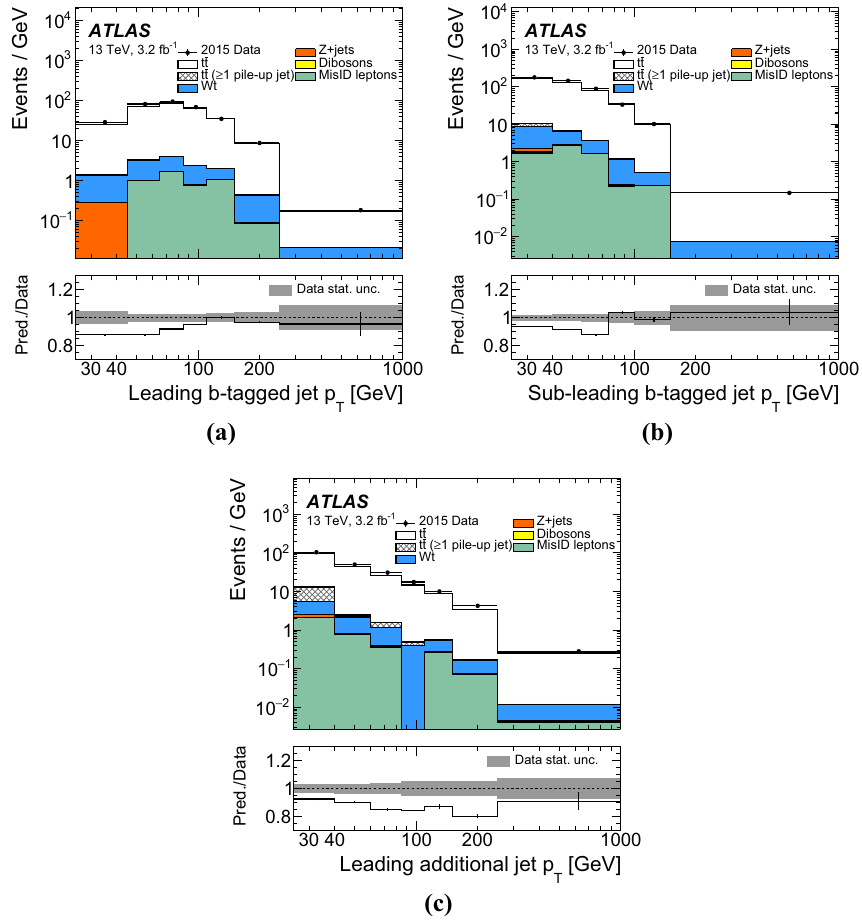
Fig. 2 a Leading b -taggedjet p T , b sub-leading b -taggedjet p T , and c leading additional-jet p T for selected events at reconstruction level. The last bin includes overflows. Jets identified as pile-up in the t ¯ t signal sample are indicated in grey . The contribution of pile-up jets to the backgrounds is negligible. The lower panel shows the ratio of the total prediction to the data ( solid line ), the grey band represents the statistical uncertainty of the measurement, and the error bars on the solid line shows the statistical uncertainty in the signal MC